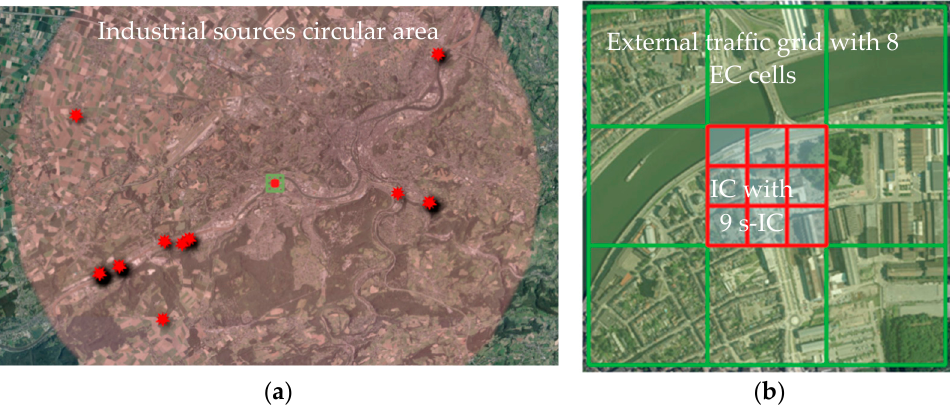
Figure 3. Areas containing variables useful for the calculation of the AQOI: ( a ) Circular area considered for the location of industrial sources of pollution potentially influencing IC air quality, in pink (radius: 15 km). Red spots represent industrial sources. ( b ) Index cell IC (300 m × 300 m) (in red) with its nine subcells (s-IC). IC is centered on the administration building of Seraing. External cells (EC) in green (Service Public de Wallonie, Orthophotos 2018—Service de visualization REST. Visualization with QGIS V3.16.7).